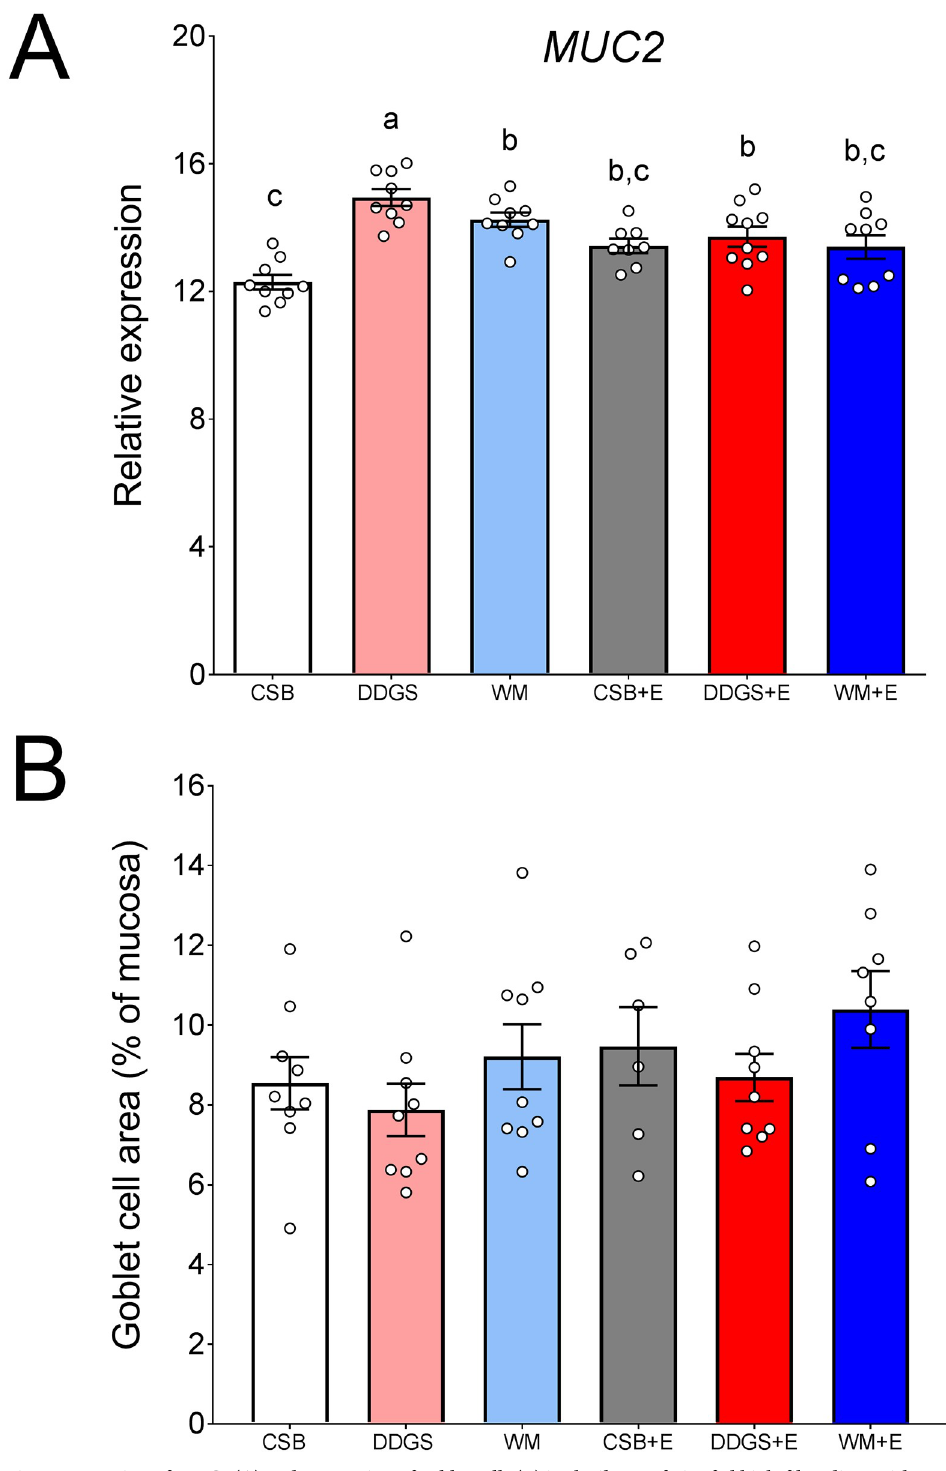
Fig 1. Expression of MUC2 (A) and proportion of goblet cells (B) in the ileum of pigs fed high-fiber diets, with or without carbohydrase enzyme cocktail supplementation, for 28 days. Data are presented as mean ± standard error of the mean. Treatment groups with different superscripts are different ( P >